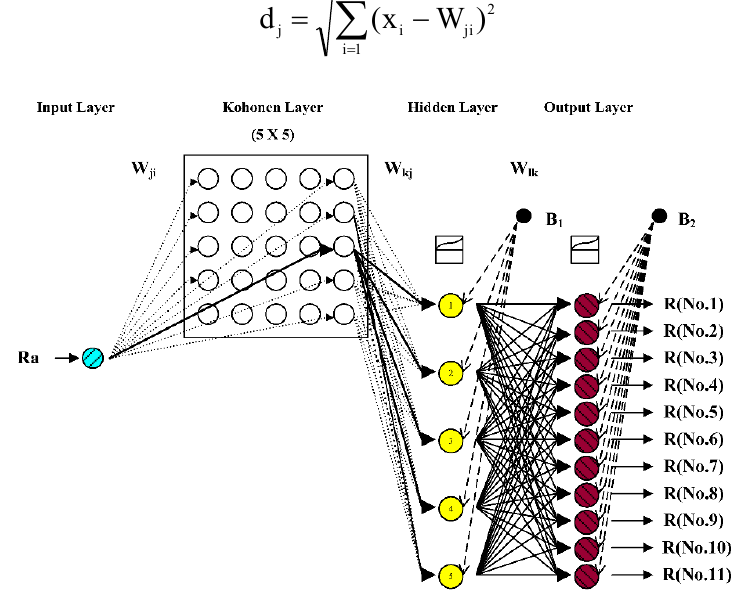
Figure 6. Structure of KSOFM (1-[5 X 5]-5-11) developed for spatial disaggregation of areal